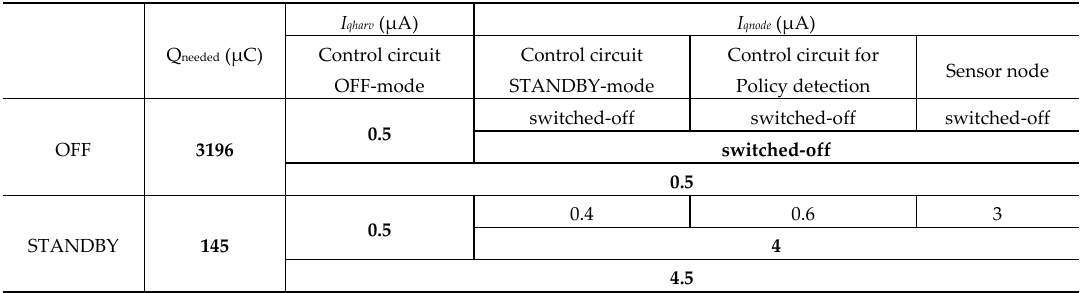
Table 3. Quiescent currents of harvesting module and sensor node during recharge phase.